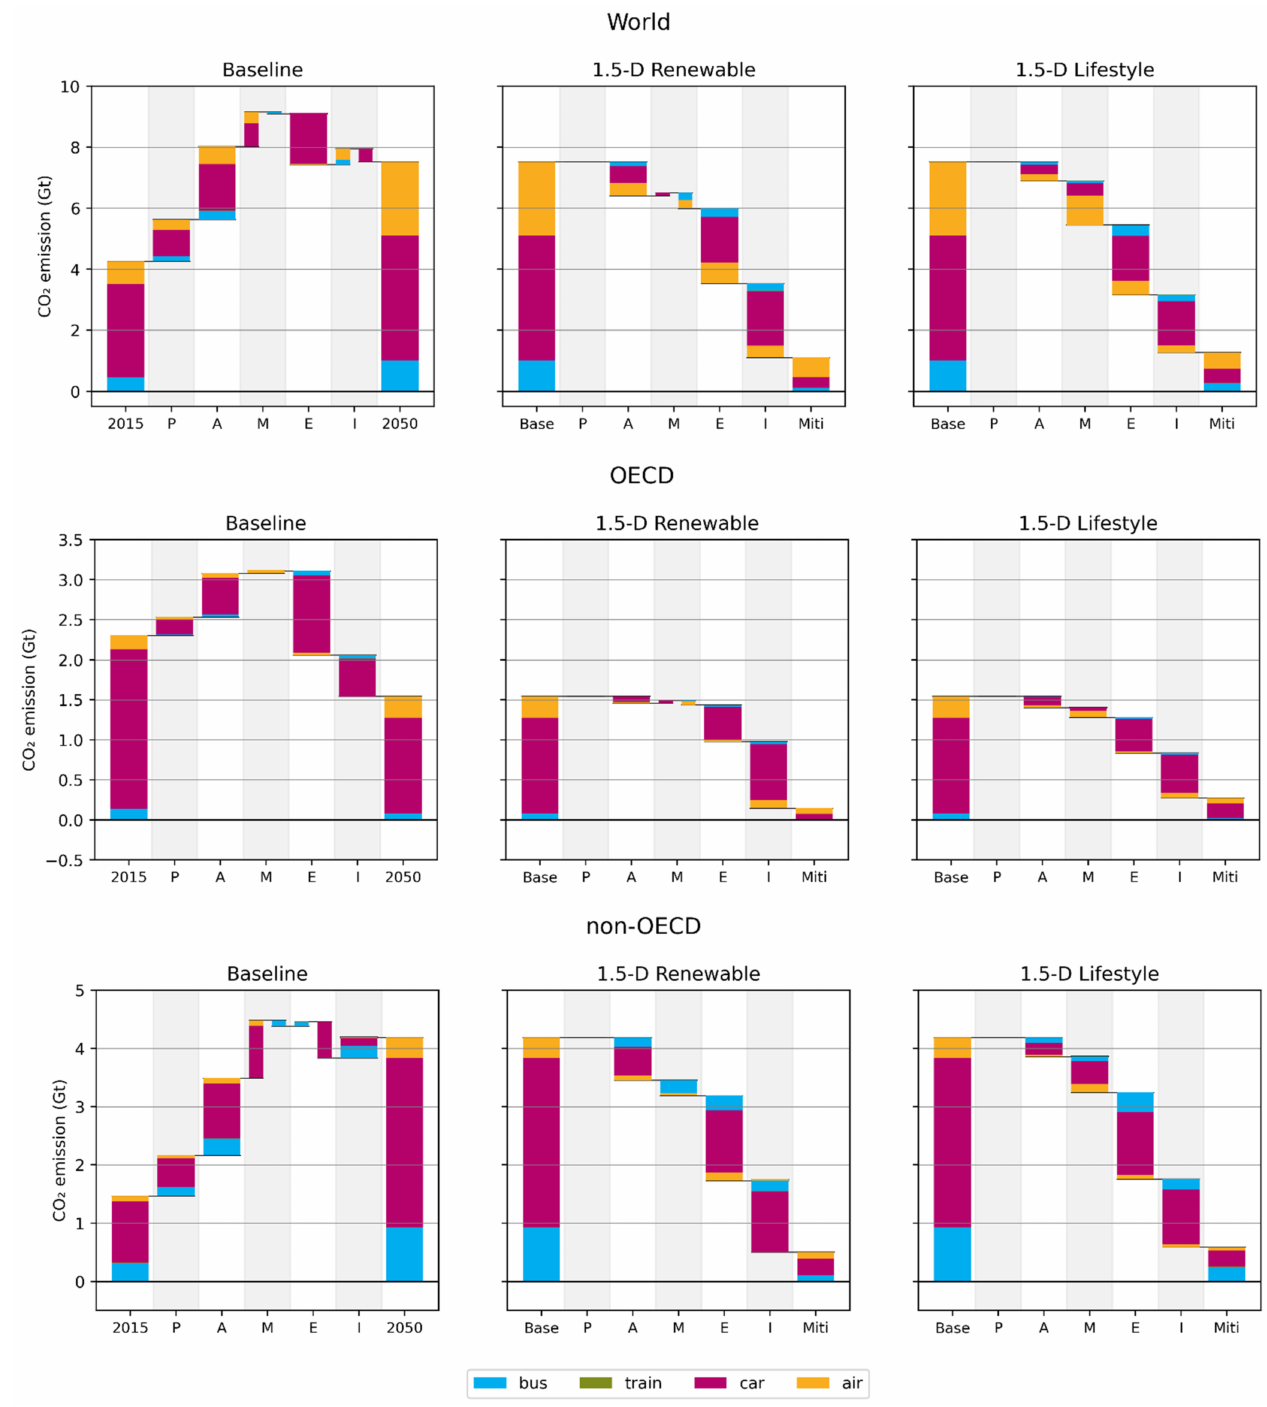
Figure 6. Changes in passenger travel emissions between 2015 and 2050 (Baseline) and between the Baseline and mitigation scenarios (in 2050) due to different drivers. P: population; A: activity; M: mode shift, E: efficiency, I: carbon intensity (includes the impact of electrification). Emissions from international bunkers are shown in global graph